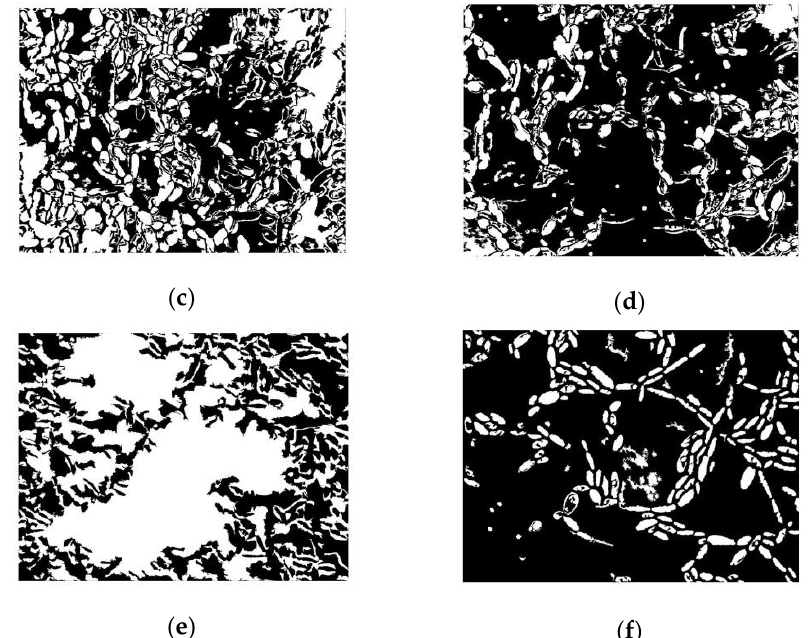
Figure 1. Example of the image analysis of the adhesion assays: image obtained from the microscope converted to grey scale ( a ) and after image process analysis in Matlab ® 6.1 ( b ). Images after image process analysis of the different surfaces tested for adhesion: polystyrene ( c ), glass ( d ), teflon ( e ), and PET ( f ).